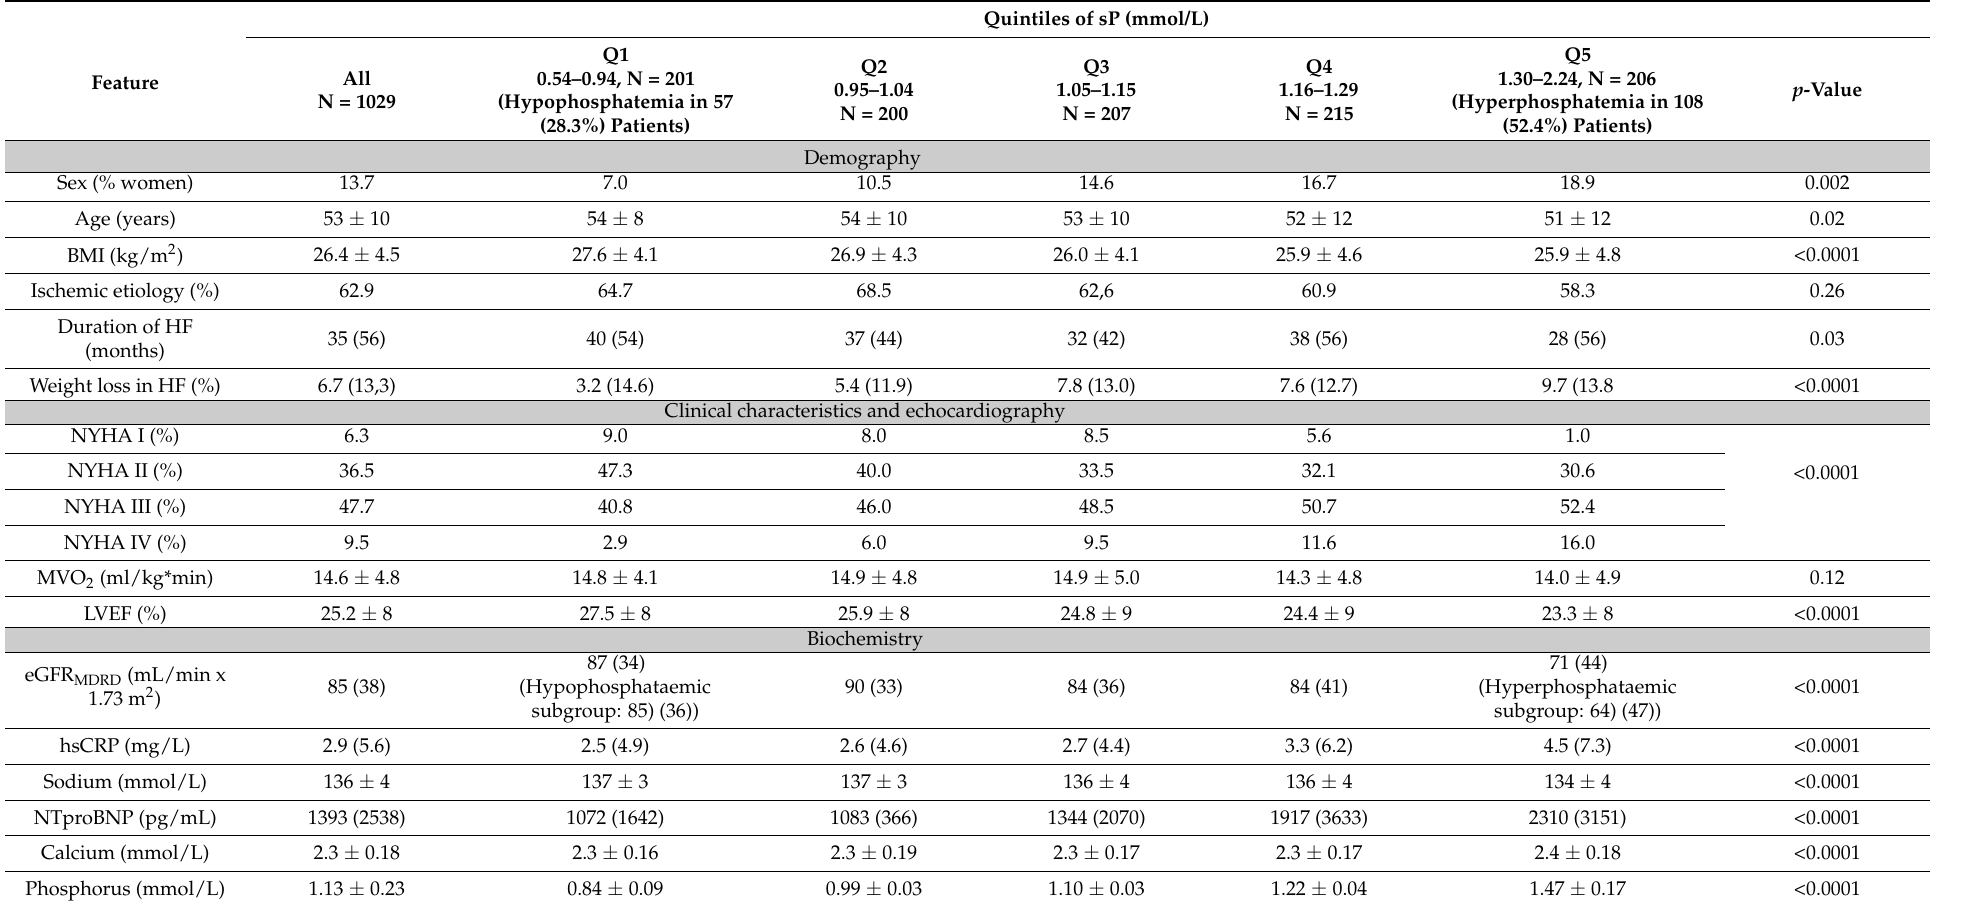
Table 1. Clinical characteristics of the study cohort. Data are presented as mean ± SD, median value with quartile range, or as